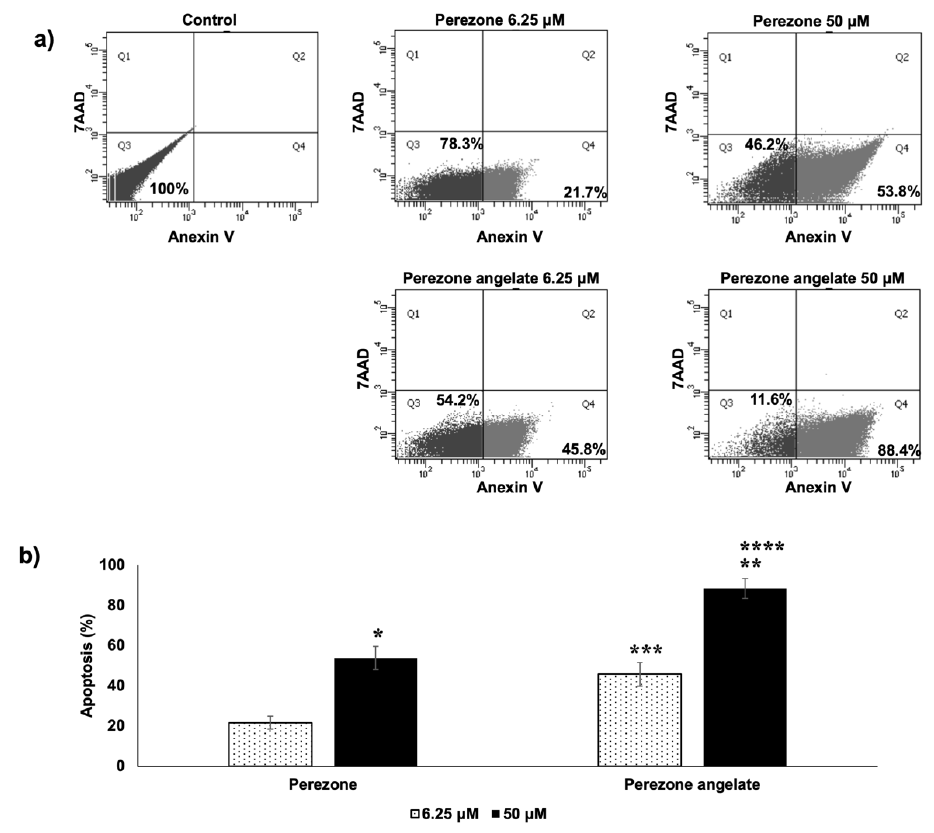
Figure 3. U373 cells were marked with Annexin V-FITC+/7AAD- (apoptotic) under perezone and perezone angelate treatment. Cells were incubated in the absence and presence of studied compounds for 48 h at 6.25 and 50 μ M ( n = 3). After Annexin-V/7-AAD staining, cells were analyzed by flow cytometry. ( a ) Representative histograms and the percentage of apoptotic U373 cells; ( b ) In the graph bar, each one indicates the percentage of mean apoptotic cells ± SEM, statistical differences were calculated by one-way ANOVA followed by a Tukey post hoc test, * p < 0.05 between perezone 6.25 μ M and perezone 50 μ M, ** p < 0.05 between perezone angelate 6.25 μ M and perezone angelate 50 μ M, *** p < 0.05 between perezone 6.25 μ M and perezone angelate 6.25 μ M, **** p < 0.05 between